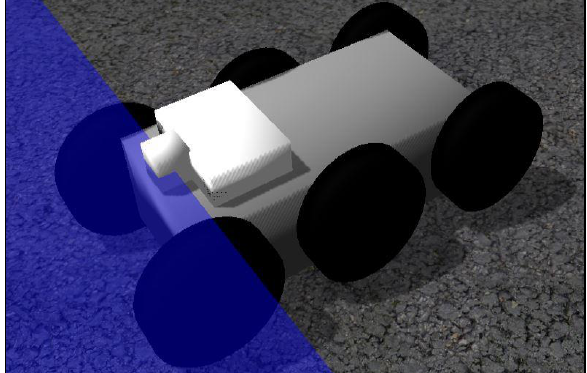
Figure 5. Robot modelled using ROS URDF